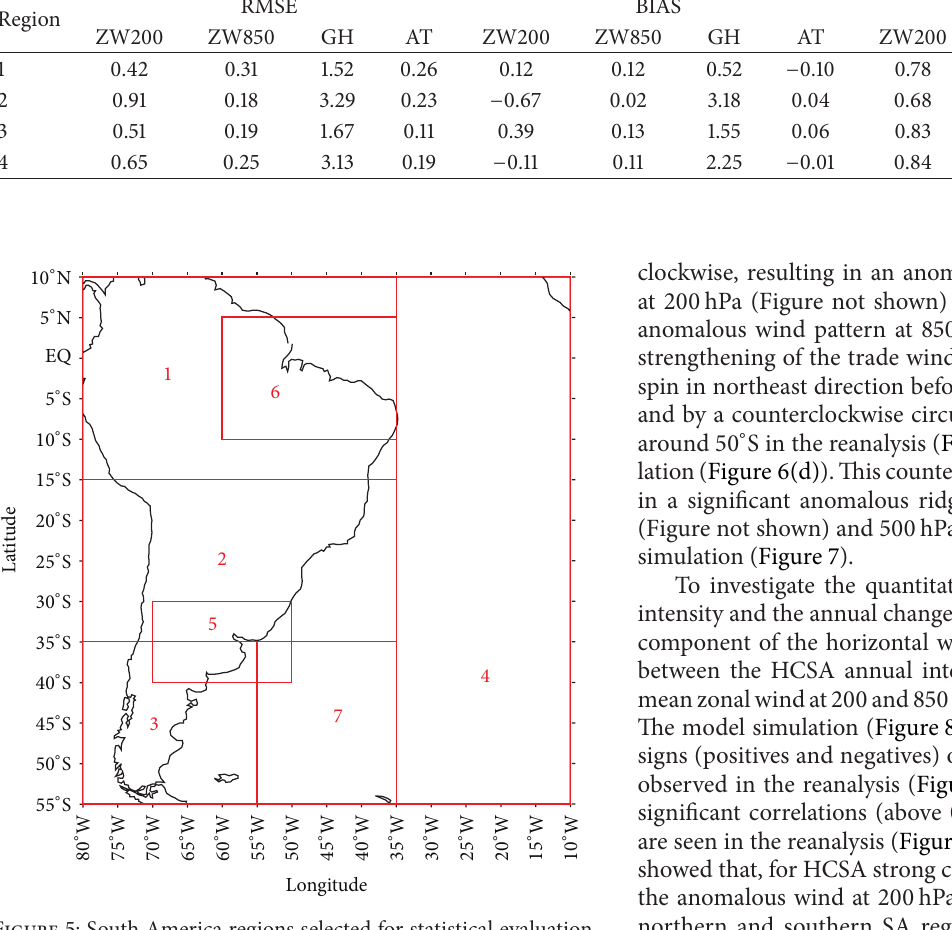
Figure 5: South America regions selected for statistical